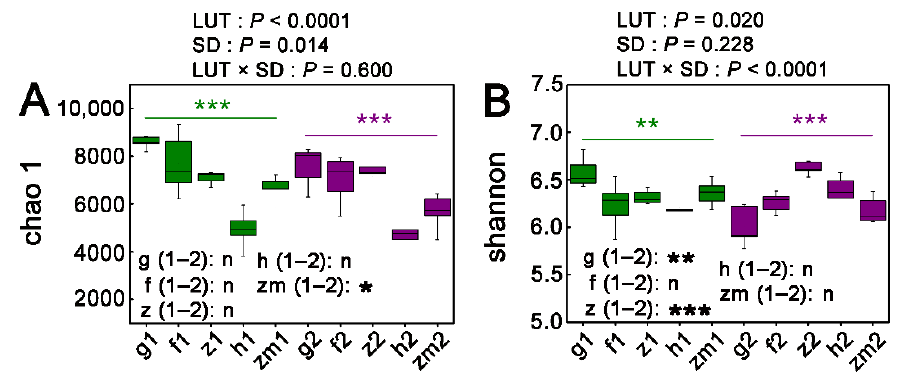
Figure 2. Effect of the different types of land use on soil bacterial alpha diversity: ( A ) Chao1, ( B ) Shannon. ** and *** above green line and purple line indicate obvious difference at p < 0.01 and p < 0.001 at 0 – 20 cm and 20 – 40 cm soil depths, respectively, in the five different land use types (ANOVA); n is not statistically significantly different among the five different land use types (ANOVA). *, ** and *** after g/f/z/h/zm (1 – 2) indicate obvious difference at p < 0.05, p < 0.01 and p < 0.001 between 0 – 20 cm and 20 – 40 cm soil depth in the five different land use types, respectively